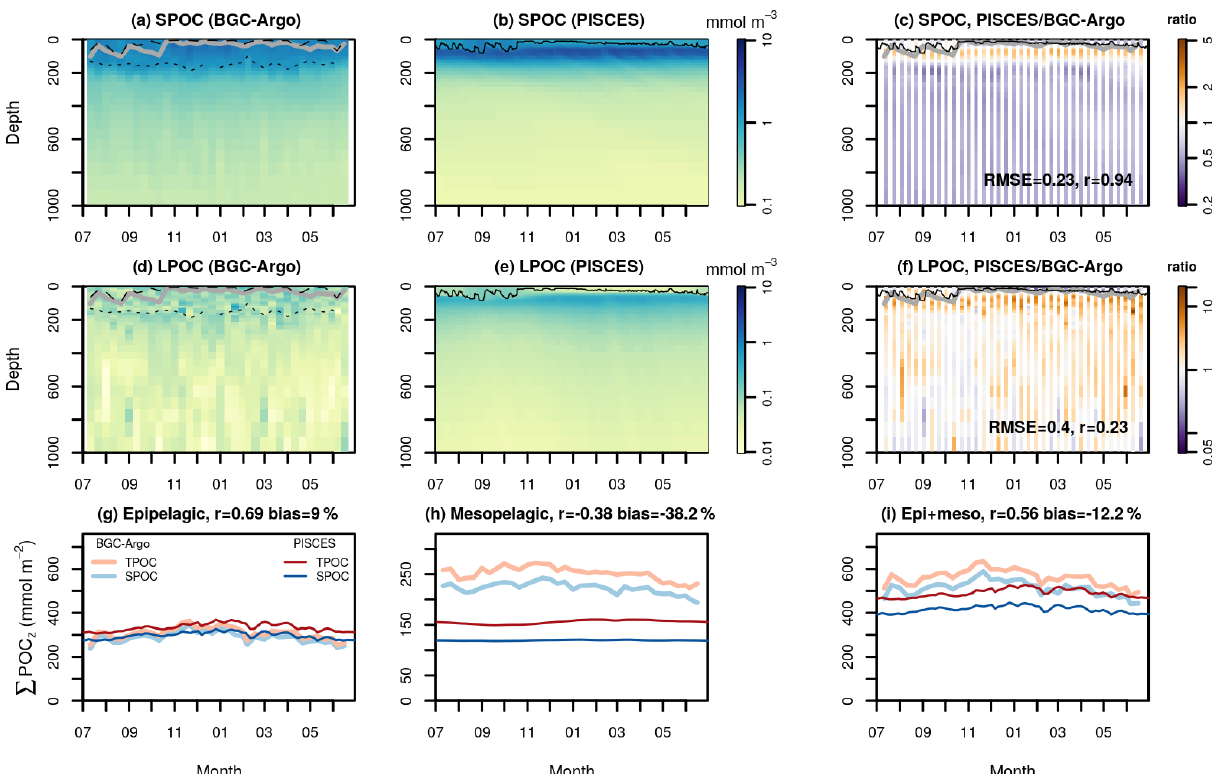
Figure 7. Temporal evolution of small and large POC concentrations (SPOC and LPOC, respectively) in the South Pacific subtropical gyre (STG). Panels (a) and (d) show observations from the BGC-Argo float WMO 6901660, which drifted westwards near Tahiti, during the year 2016. Panels (b) and (e) show the corresponding PISCES 1D simulation. Panels (c) and (f) show the ratio between the model and the observations and the corresponding correlation coefficient and RMSE in log 10 scale. Solid lines depict the observed MLD ( a and d , in gray) and the simulated turbocline depth ( b and e , in black). In panels (a) and (d) , the dotted lines show the depths of the maximum Chl a fluorescence gradient and the dashed lines an alternative MLD estimated with a 0.005 ◦ C temperature threshold that captures weak stratification. The bottom panels show the vertically integrated SPOC and LPOC stocks in different layers: 0–200m or epipelagic (g) , 200– 1000m or mesopelagic (g) , and 0–1000m (i) . On top of panels (g) – (i) we show the correlation and mean bias between BGC-Argo and PISCES total POC